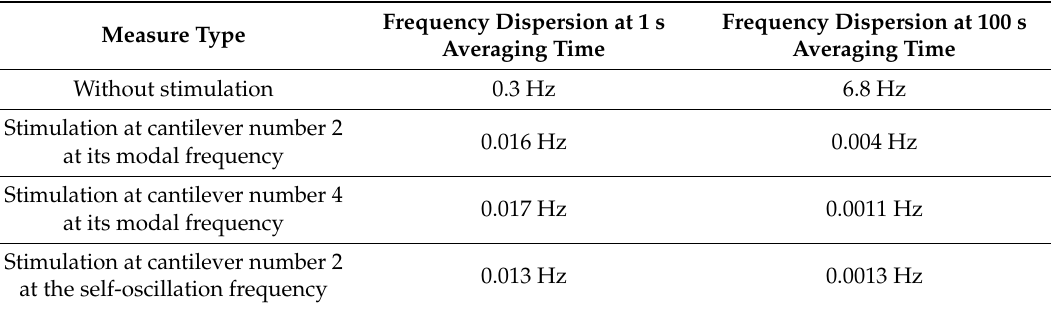
Table 1. Frequency dispersion for different averaging